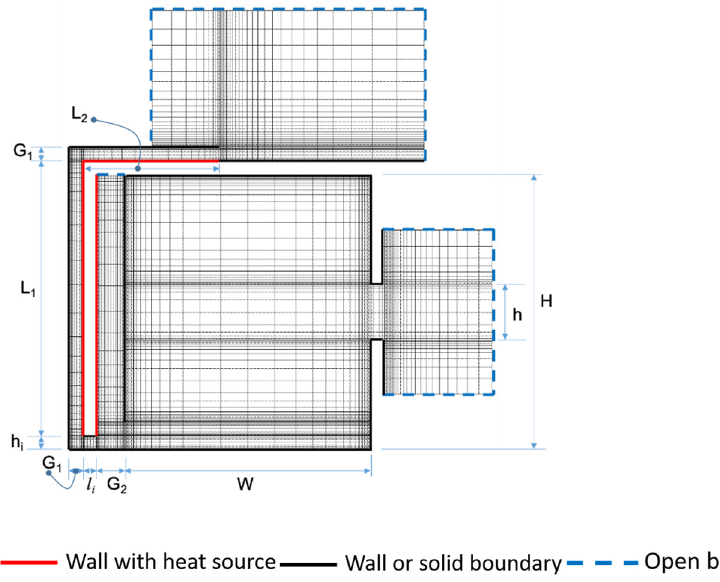
Figure 2. Configuration (II): Computational domain and mesh.